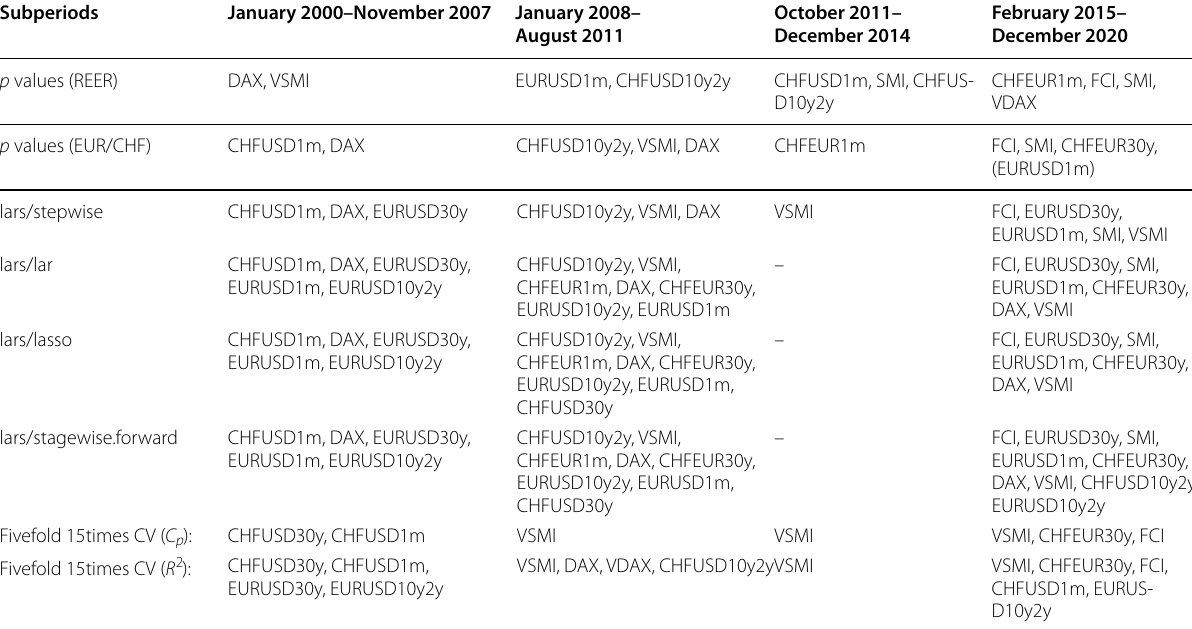
Top panel (first row): Drivers for the real effective exchange rate selected according to the method described in Sect. 2.1. Middle panel (second row): Drivers for the observed exchange rate selected according to the method described in Sect. 2.1. Bottom panel (remaining rows): Drivers for the observed exchange rate selected by different methods from the lars package and by two variants of cross-validation